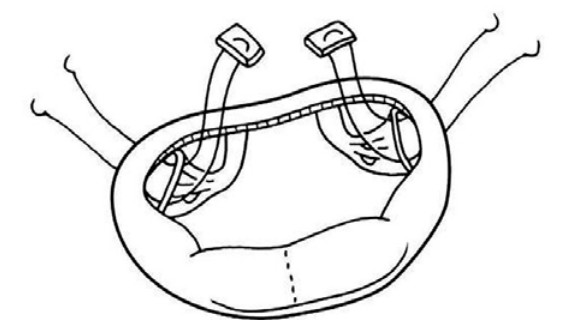
Fig. 3 - The anterior and posterior parts of the anterior leaflet are re-attached to the mitral ring near the anterolateral and posteromedial commissures